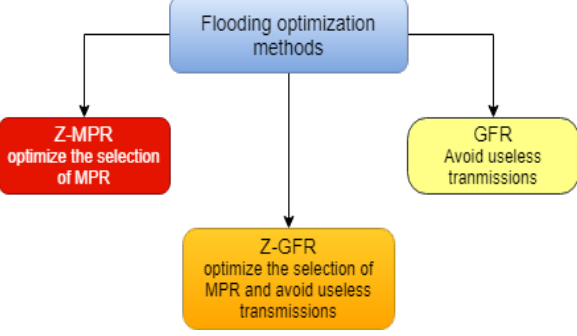
Figure 1. Z-GFR: Two optimization